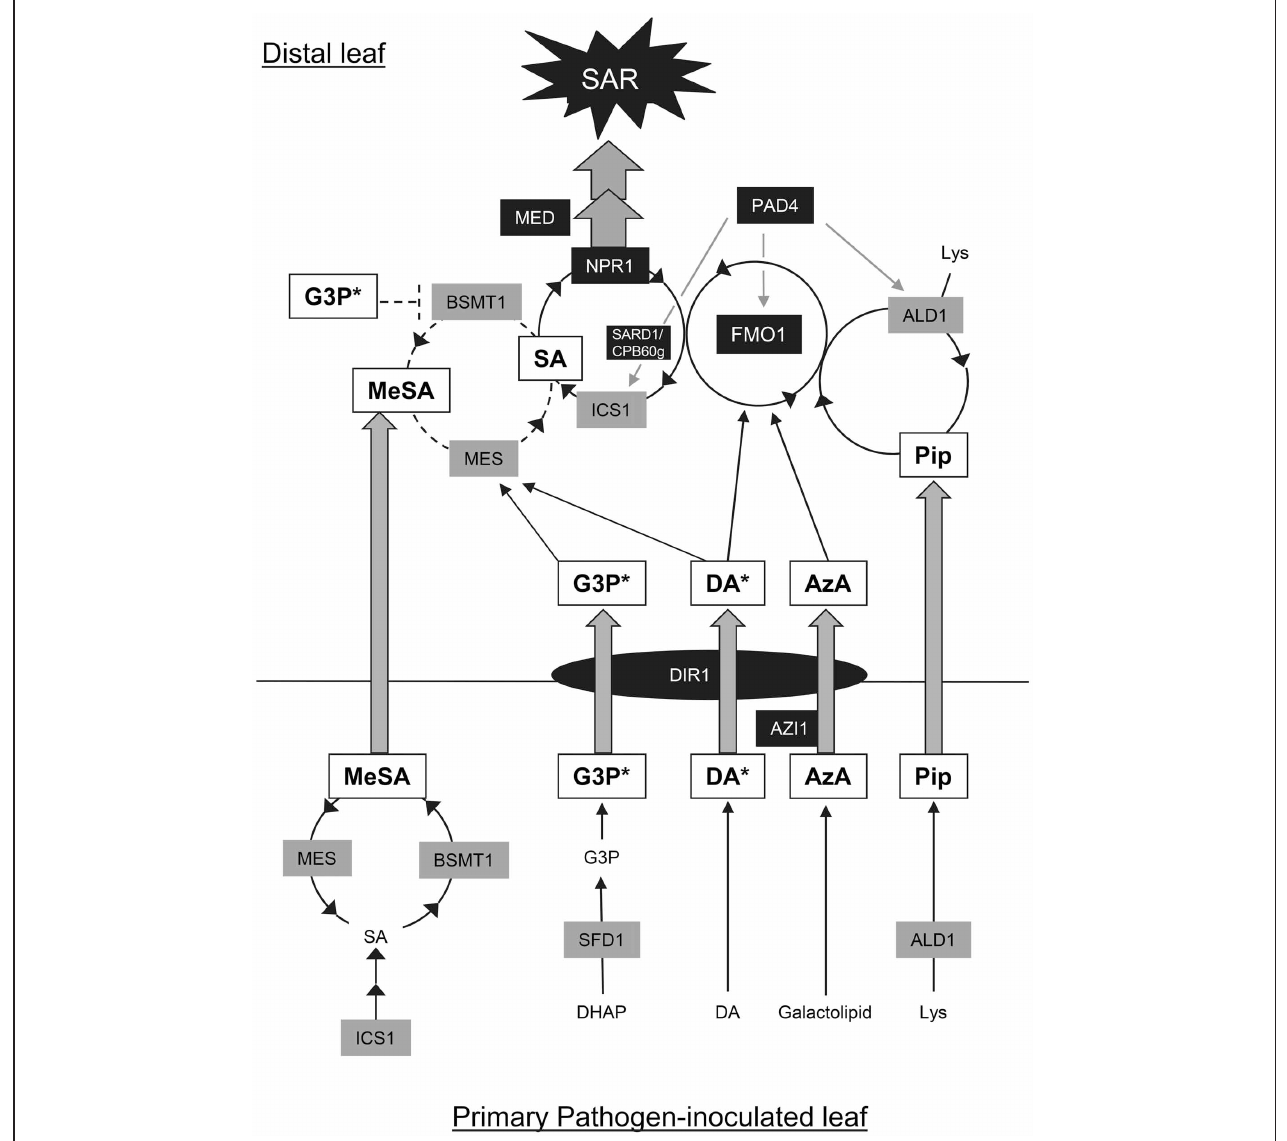
FIGURE 3 | SAR circuitry involving a network of signaling molecules. Studies in Arabidopsis and to a lesser extent in tobacco have indicated that multiple signaling molecules participate in SAR and that the role of some of these signals is influenced by the environment. The genes listed in this model are from Arabidopsis. Events in the primary pathogen-infected leaf: In Arabidopsis, increased activity of ICS1, resulting from pathogen-induced expression of the corresponding gene, provokes increased SA accumulation. A fraction of the accumulating SA is converted to MeSA by BSMT1. In tobacco, the high level of SA was simultaneously shown to inhibit the MeSA esterase (MES) activity of SABP2, thus ensuring increase in MeSA level. Glycerol-3-phosphate (G3P), azelaic acid (AzA), and pipecolic acid (Pip) levels also increase in response to pathogen inoculation. SFD1 (GLY1) catalyzes the synthesis of glycerol-3-phosphate from dihydroxyacetone phosphate (DHAP). AzA has been suggested to be synthesized from galactolipids by a non-enzymatic method. Pip is synthesized from lysine (Lys) via the ALD1 aminotransferase and heavily accumulates in infected leaves. Expression of the ALD1 gene is induced in response to pathogen inoculation. Absolute levels of DA do not change. However, DA is mobilized from a non-signaling low-molecular weight to a high molecular weight signaling DA (DA*) complex